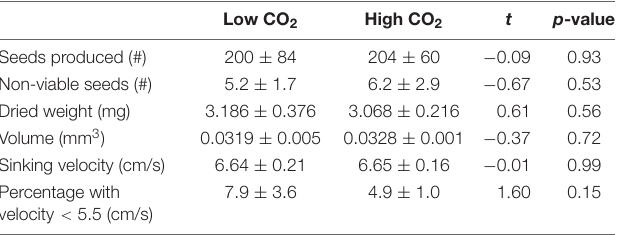
TABLE 3 | Mean ( ± SD) of seed quantity and metrics of seed quality produced from flowering shoots maintained in low and high CO 2 conditions for 69 days (Experiment 1).